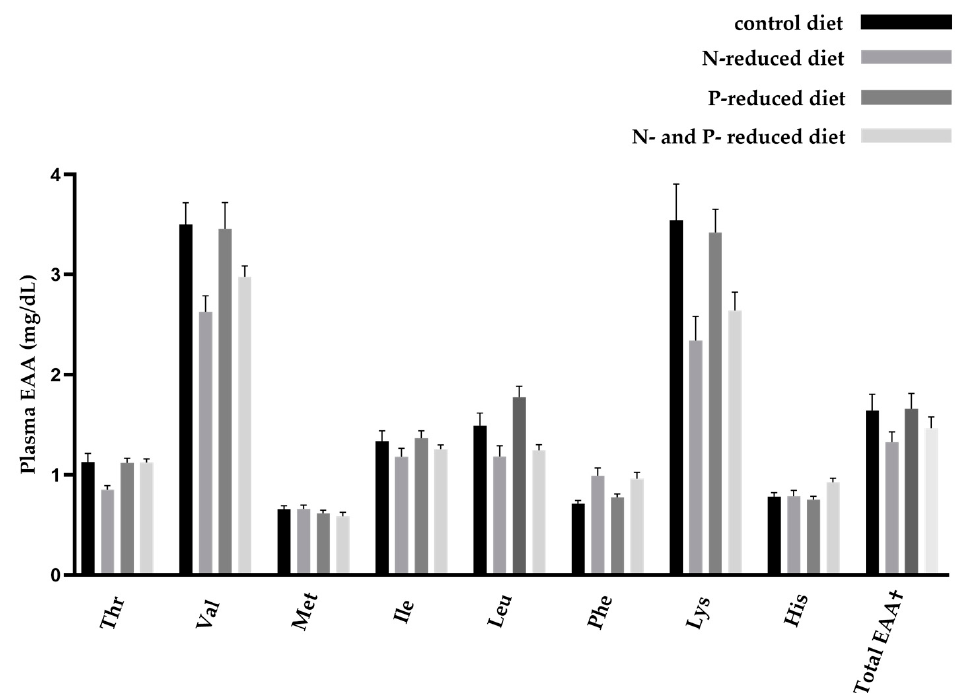
Figure 1. Overview of circulating essential amino acids (EAA) in young goats fed an N- and/or P-reduced diet. Mean values with their standard errors. Mean values that differ significantly in the Tukey test are shown in Table 4 with different superscript letters. n = 7 animals. † n = 56 animals.